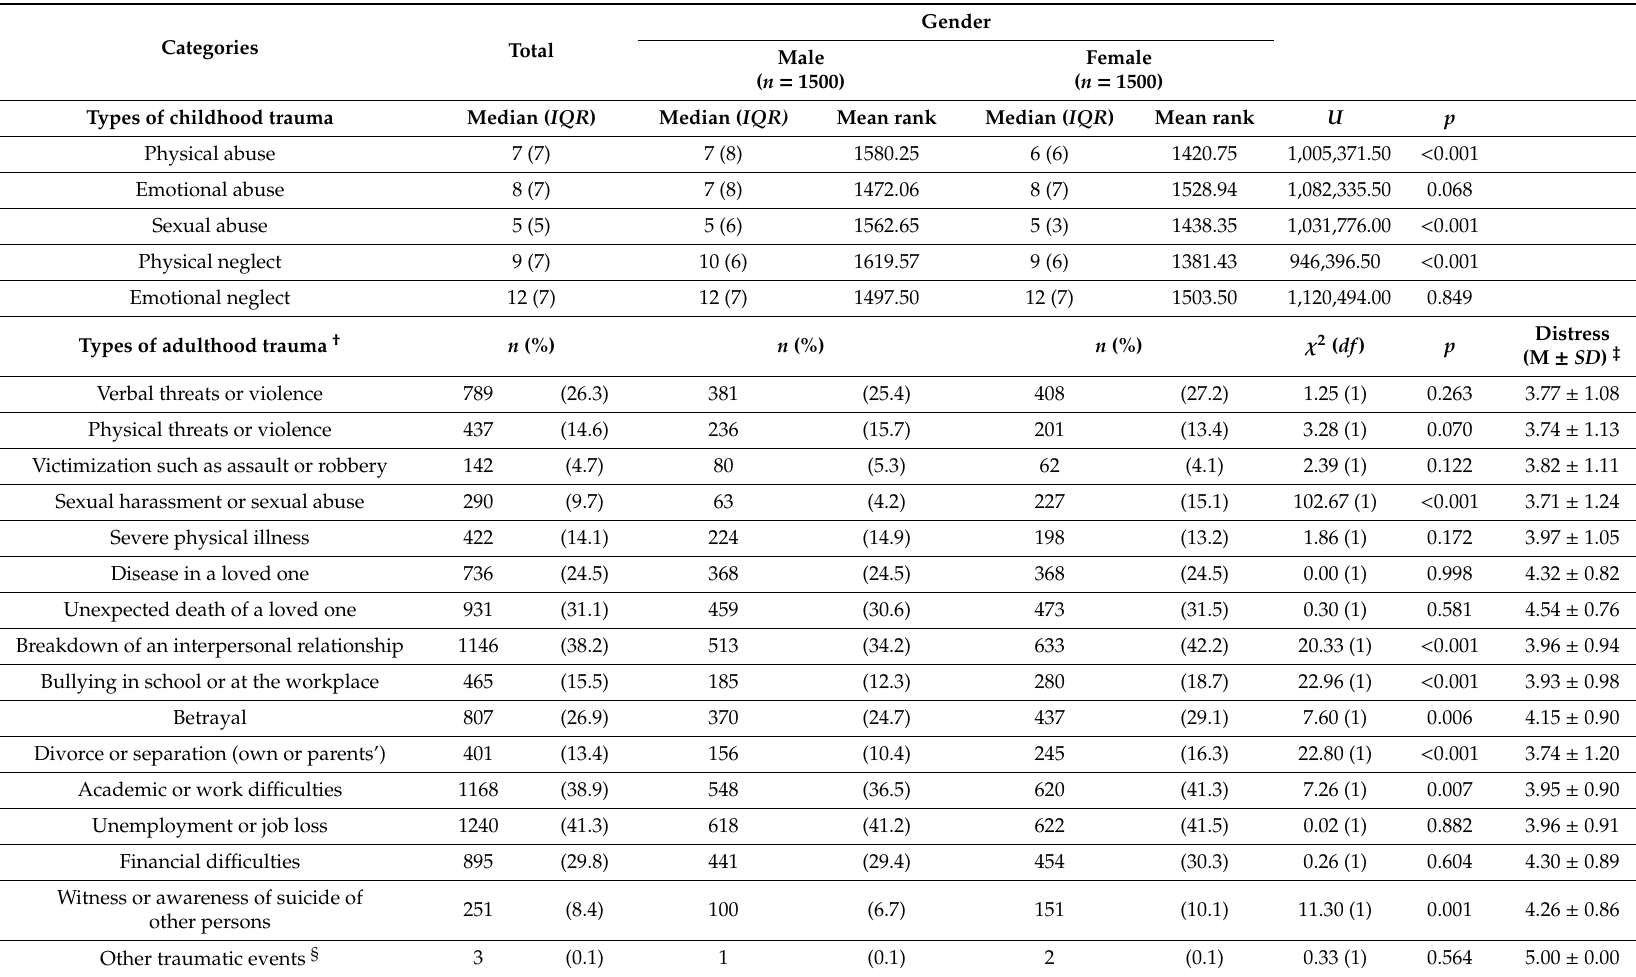
Table 2. Characteristics of childhood and adulthood trauma and its di ff erences by gender ( N =